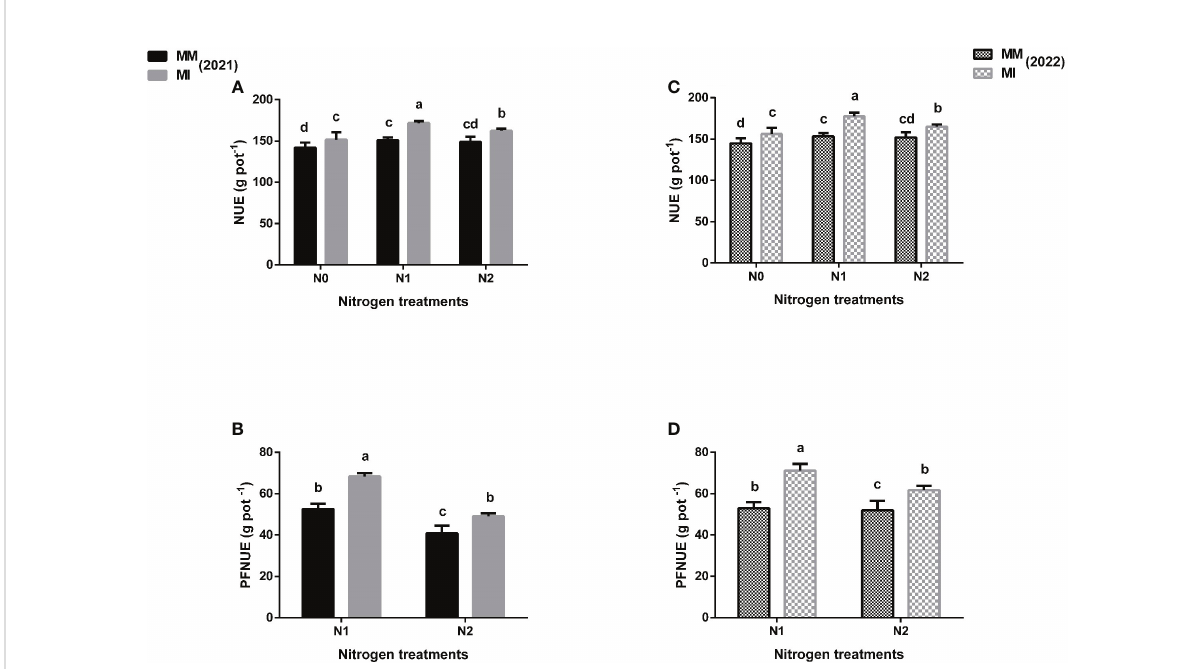
FIGURE 4 Maize nitrogen use ef fi ciency (NUE) (A, C) , partial factor nitrogen use ef fi ciency (PFNUE) (B, D) under different planting patterns (MM, maize mono- cropping and MI, maize intercropping) and N fertilizer application rates (N 0 ; 0 kg N ha -1 , N 1 ; 250 kg N ha -1 and N 2 ; 300 kg N ha -1 ) in 2021 and 2022 crop growing seasons. The column bars with dissimilar lowercase letters are signi fi cantly different from each other as per the LSD test ( p < 0.05).